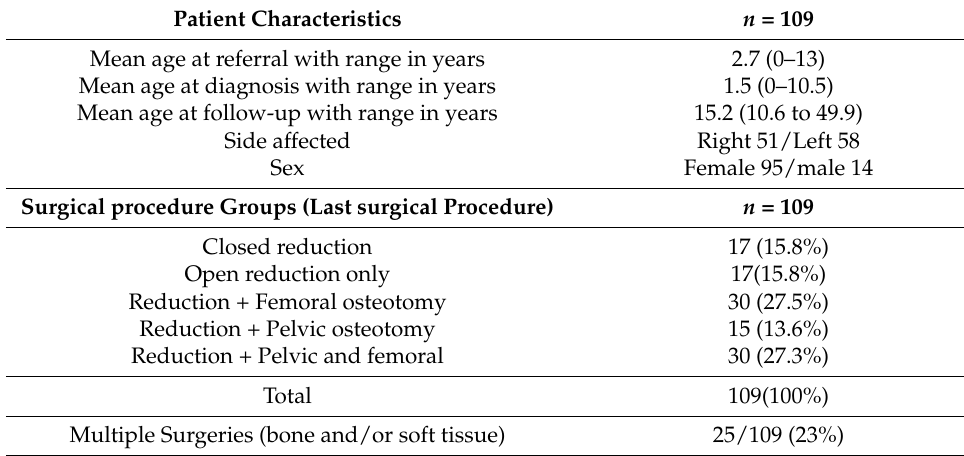
Figure 2. Patient inclusion and exclusion flow-chart. Table 1. Patient demographics and frequency procedure types.